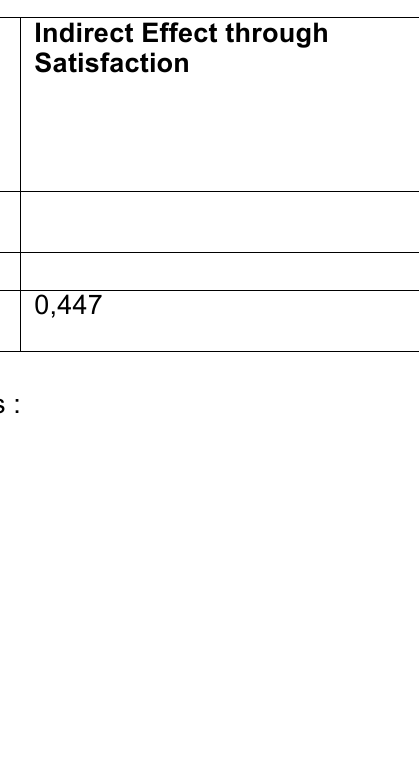
Table 5: The Direct, Indirect, and Total Effect of Services Quality, Customers’ Satisfaction